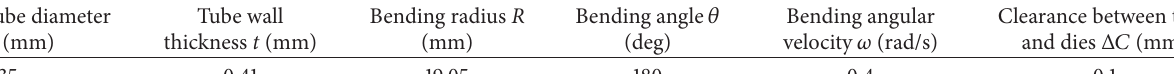
Figure 6: Types of the hard mandrel: (a) cylinder mandrel; (b) bulb mandrel. Table 3: Simulation parameter.